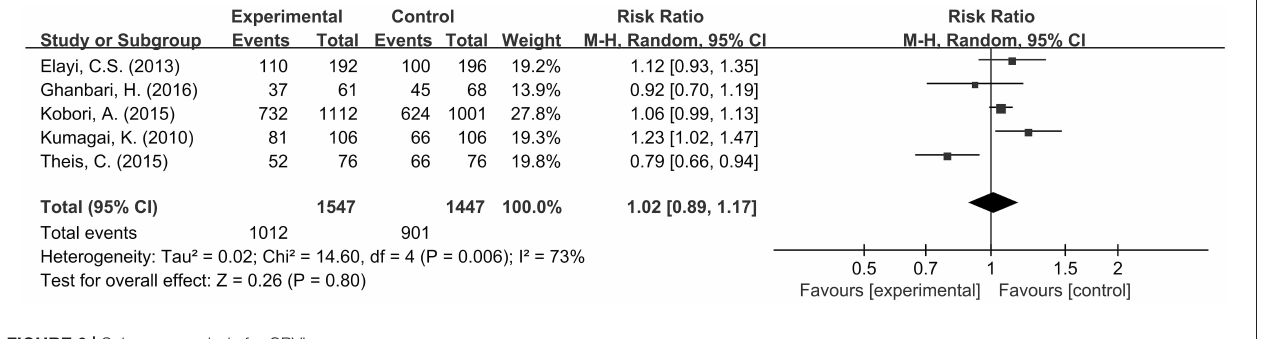
FIGURE 6 | Subgroup analysis for CPVI.